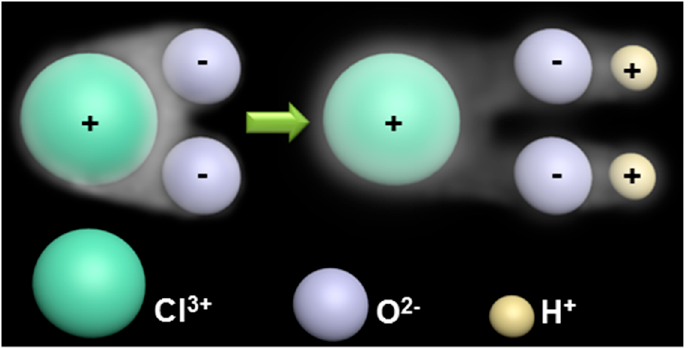
Figure 8. Schematic diagram of hydrogen ion depolarization.